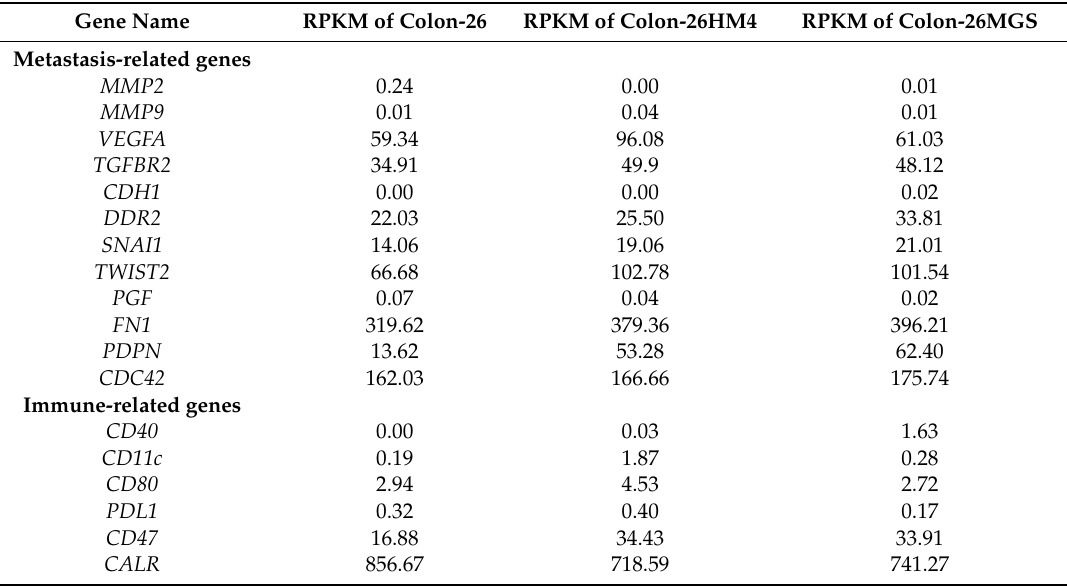
Table 1. Gene expression by next-generation sequencing (NGS).